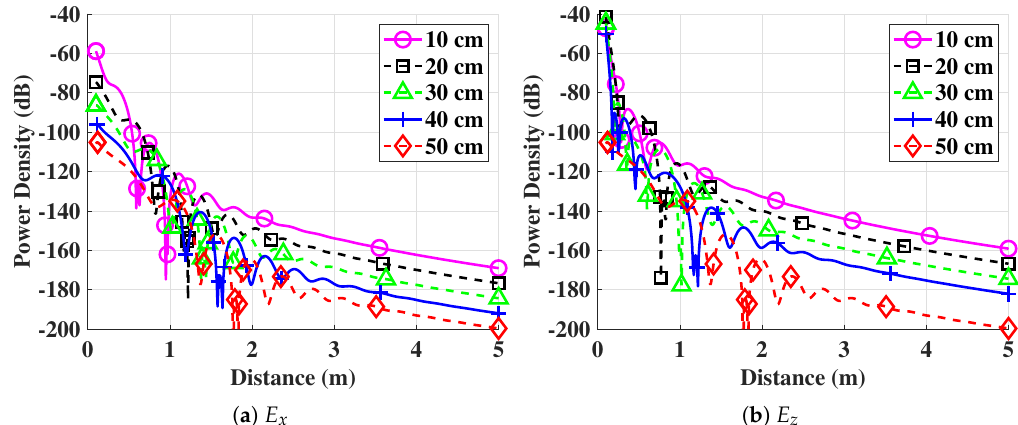
Figure 5. The power density for different burial depths: ( a ) E x component; ( b ) E z